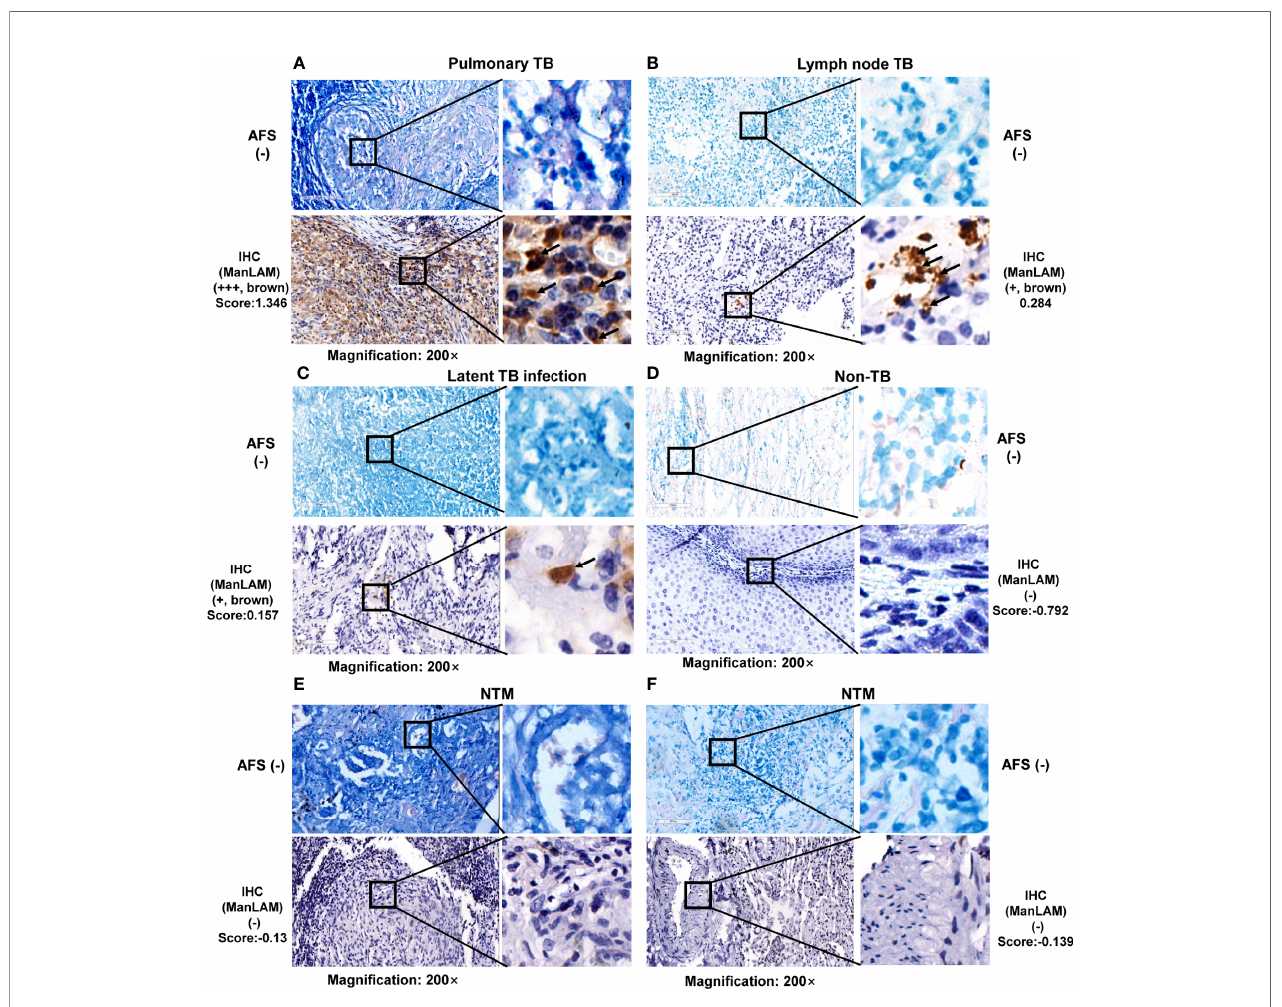
FIGURE 3 | Representative images and comparison between acid-fast staining (AFS) and ManLAM aptamer-based IHC in lesion tissues with negative AFS. Representative images of (A) tissues of pulmonary tuberculosis (TB) patient, (B) lesion sections of lymph node TB patient, (C) lesion sections of LTBI patient, (D) lesion sections of non-TB patient, (E, F) lesion sections of two NTM patients. TB, tuberculosis. NTM, nontuberculous mycobacteria. Arrows indicate positive signals (aptamer-based immunohistochemistry (IHC) by brown granular staining; AFS by red staining). Samples with a score less than the cutoff value (0.0580) were designated as “ - ” , ( ≥ 0.0580 and <0.5010) as “ + ” , ( ≥ 0.5010 and <0.8780) as “ ++ ” , >0.8780 as “ +++ ” . The numbers (0.5010 and 0.8780) were determined by calculating the 50% and 75% percentile of the